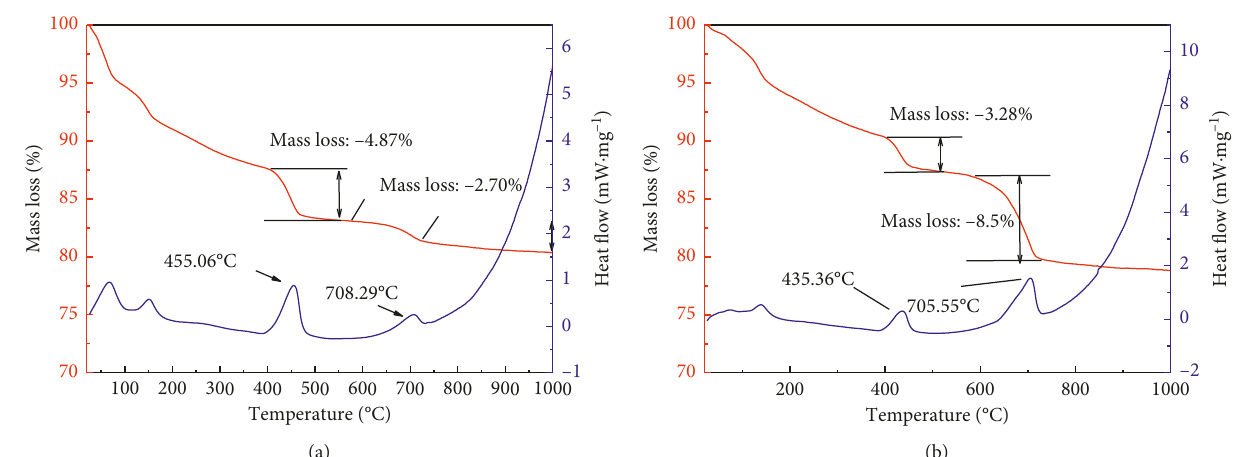
Figure 10: (a) TG-DSC curve of steel slag under 0.3 MPa CO 0.3MPa CO 2 curing for